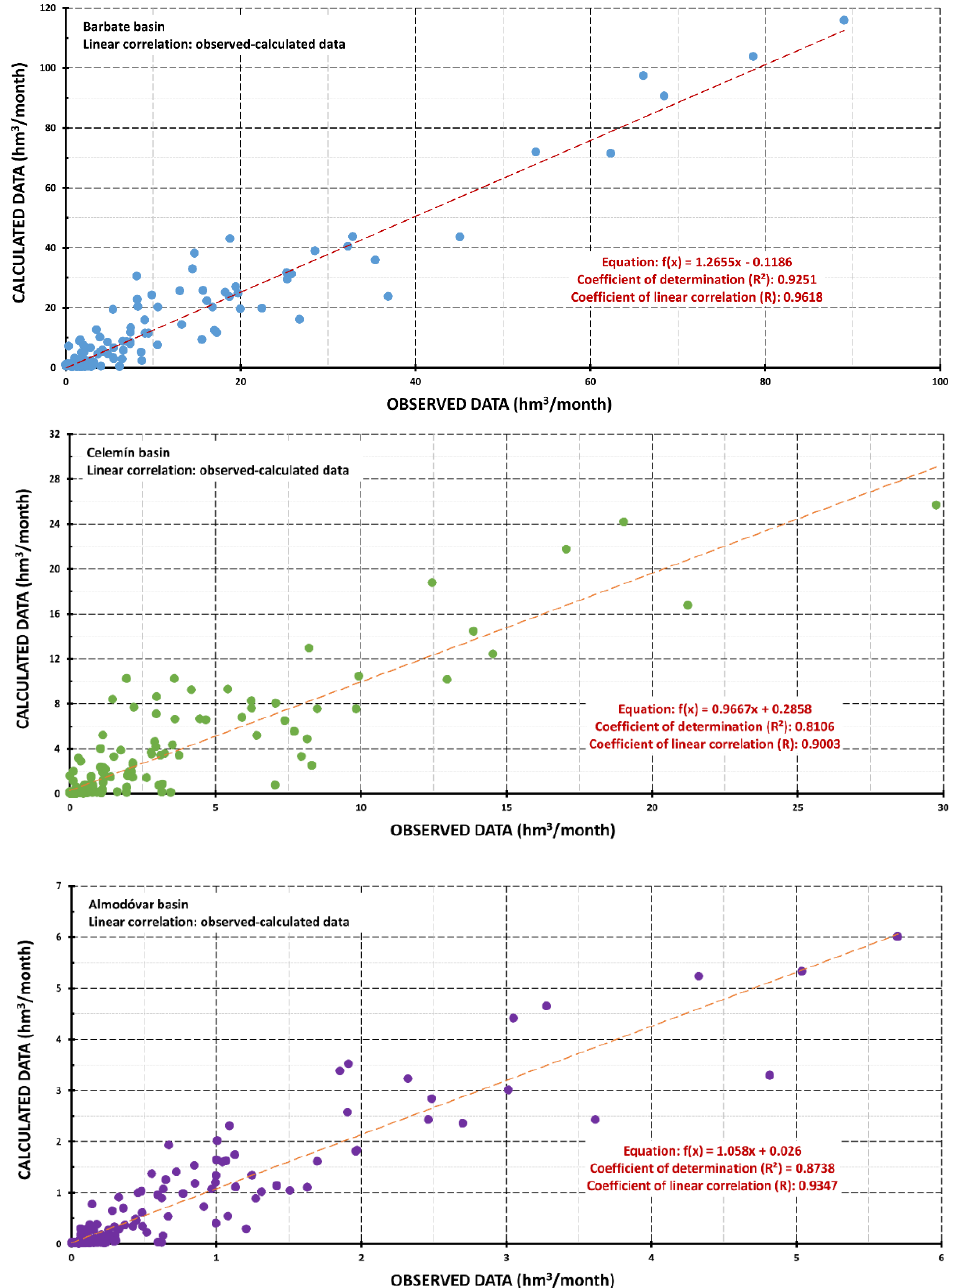
Figure 6. Linear correlation between calculated and observed data for the period 2000–2015.